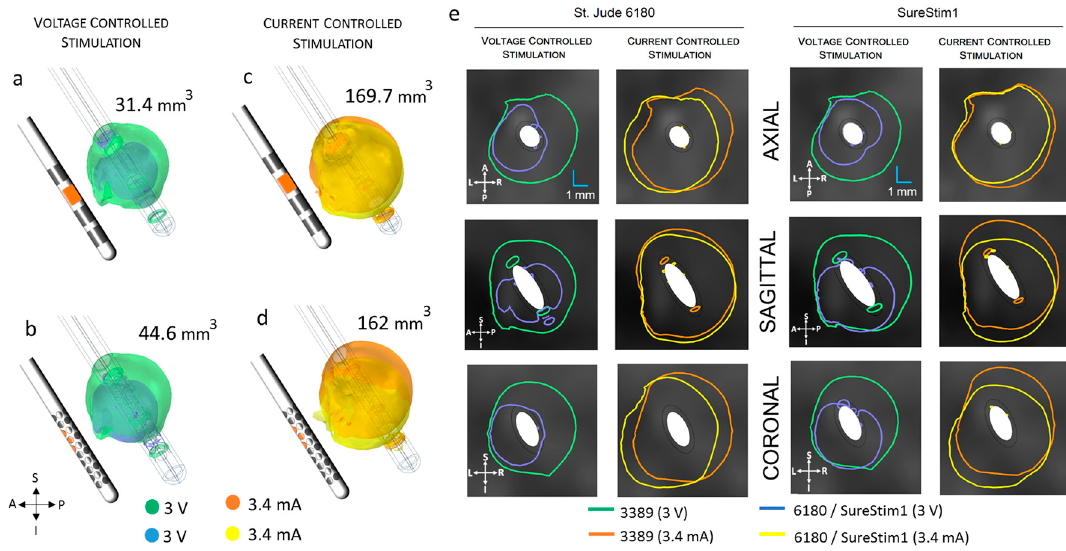
Figure 11. Comparison of the electric field (EF) isosurfaces (0.2 V/mm) at the zona incerta between the standard lead 3389 and the steering leads (active contacts shown in orange in the lead schematic). EF superimposed for lead 3389 (green/orange volumes) and ( a ) lead 6180 contact 5 active; ( b ) SureStim1 lead using the diamond configuration, operated in voltage mode (smaller volumes in blue); ( c ) Lead 6180 and ( d ) SureStim1 setting the contacts to current mode (EF volumes in yellow); ( e ) EF isocontours (0.2 V/mm) at the axial, sagittal and coronal planes for both leads operated in voltage and current mode. A: anterior, P: posterior, S: superior, I: inferior, L: left, R: right. Table 4. Maximum spatial extension of the 0.2 V/mm electric field isolevel (mm) achieved by steering configurations. Relative difference between operating modes calculated for each lead.